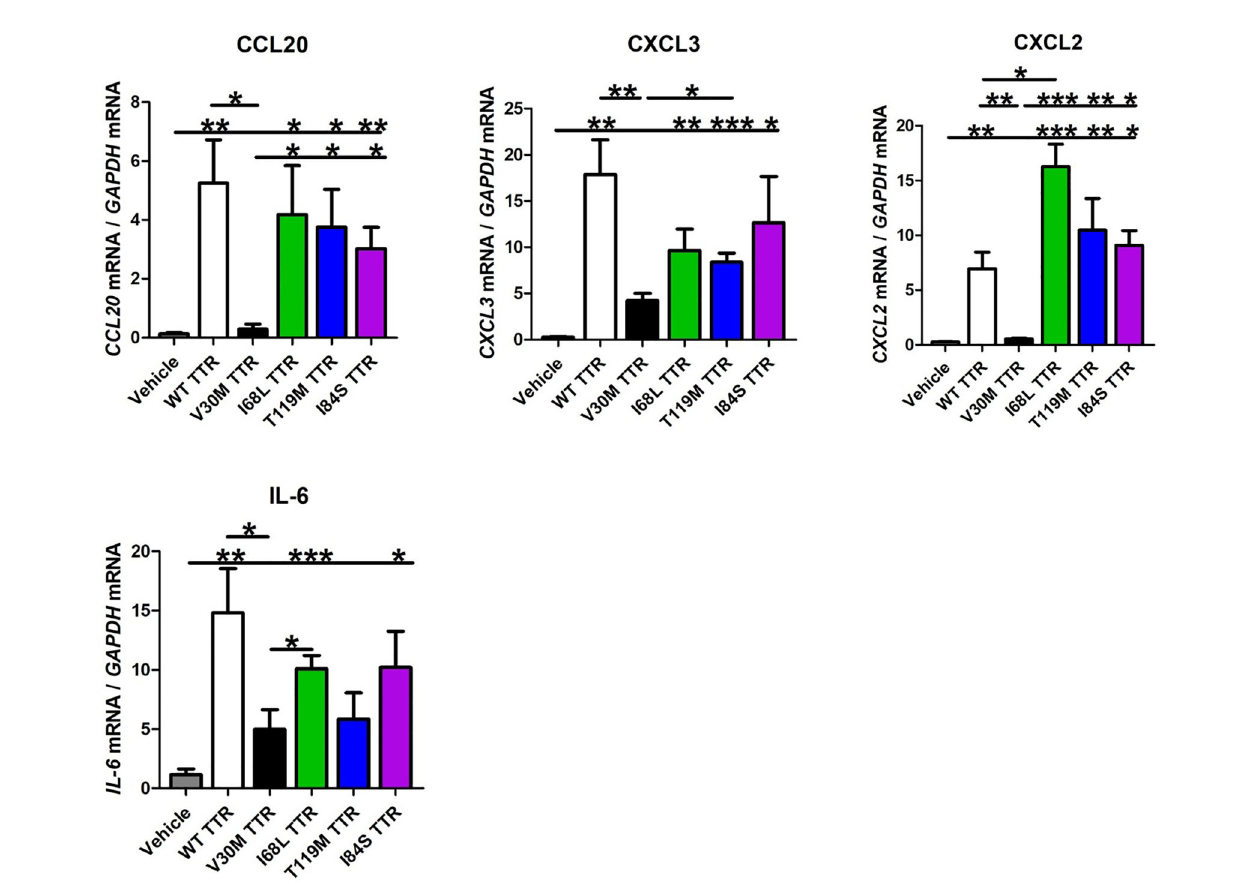
FIGURE 3 | Schwann cells are activated by other TTR variants. Schwann cells were activated by different TTR pathological or non-pathological mutations, leading to an expression of chemokines globally similar to that induced by WT TTR. IL-6 expression was also similar between SCs incubated with WT or mutant TTRs. Data were analyzed using one-way ANOVA followed by Bonferroni post-test and represented as mean ± s.e.m (*P < 0.05; **P < 0.01; ***P <